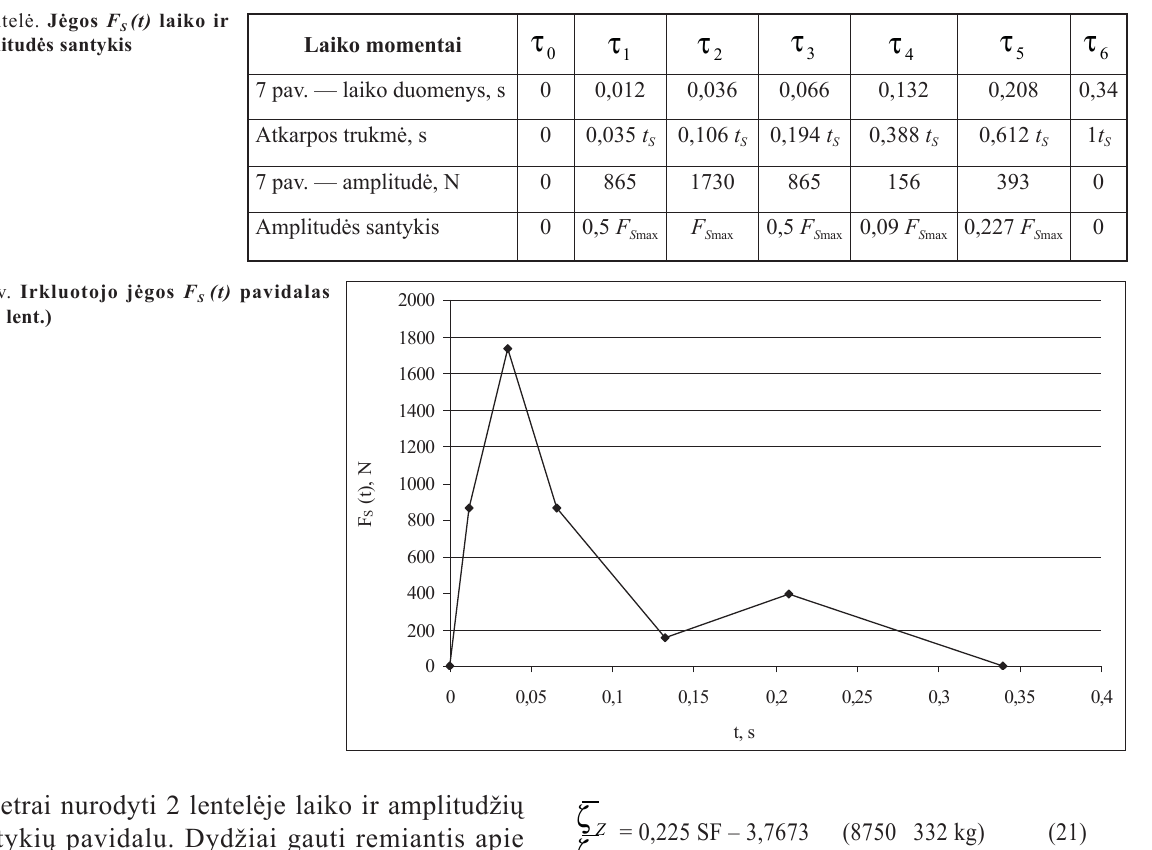
rametrai nurodyti 2 lentel ė je laiko ir amplitudži